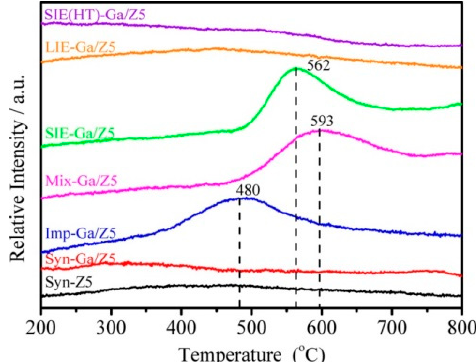
Figure 4. H 2 -TPR profiles of Ga/ZSM-5 prepared via different methods. Reprinted with permission from ref [46]. Copyright 2019 American Chemical Society.